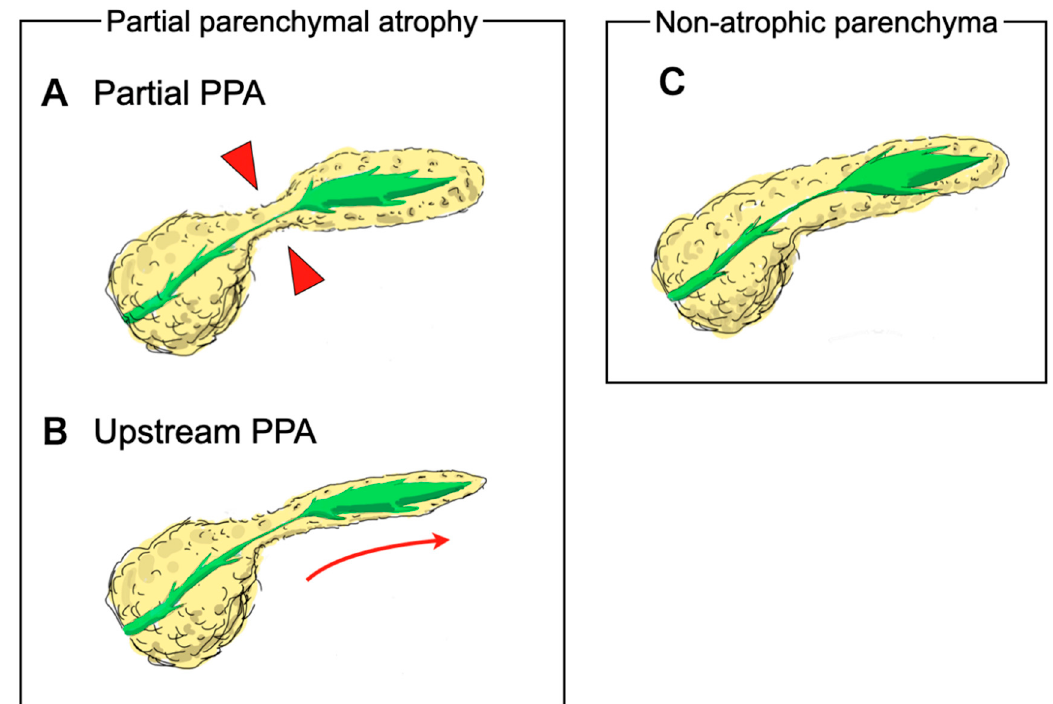
Figure 1. Illustrations of pancreatic parenchymal atrophy (PPA). PPA was categorized into partial PPA or upstream PPA. ( A ); Partial PPA was defined as an atrophic change corresponding to the distribution of main pancreatic duct (MPD) stenosis (red arrow heads). ( B ); Upstream PPA was defined as atrophic change of the whole upstream side of the parenchyma arising from the site of MPD stenosis (red arrow). ( C ); Non-atrophic parenchyma was defined as the absence of parenchymal atrophic change in the whole parenchyma despite the presence of main pancreatic duct stenosis.